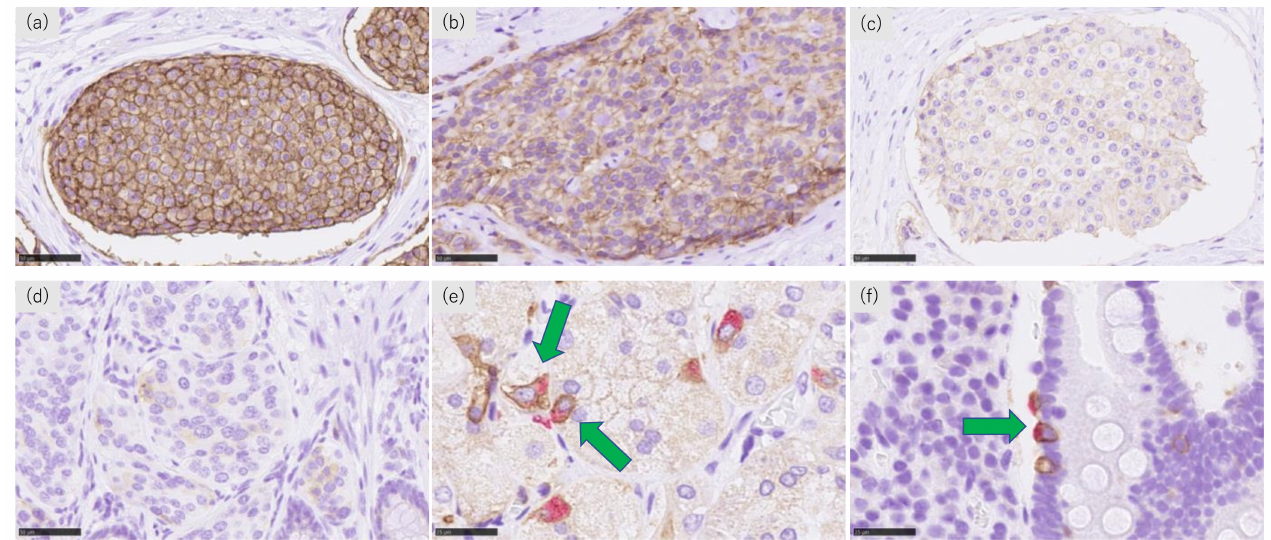
Figure 1. Representative illustrations of SSTR2 and chromogranin A immunohistochemistry. ( a ) Marked and circumferential, ( b ) moderate and incomplete, ( c ) weak and incomplete SSTR2 immunoreactivity in the membrane of tumor cells, ( d ) cytoplasmic SSTR2 immunoreactivity of tumor cells. Double immunostaining of SSTR2 and chromogranin A in the ( e ) stomach and ( f ) duodenum. Green arrows represent SSTR2 and chromogranin A double-positive neuroendocrine